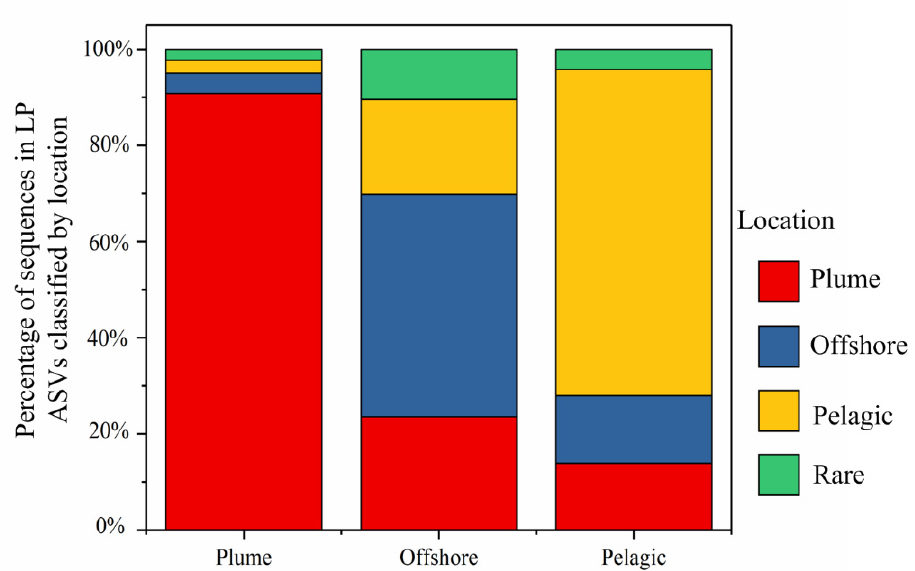
Figure 5. Percentage of sequences in LP ASVs classified by location. The rare category represents sequences belonging to ASV that make up to less than 0.1% of the total number of sequences from each corresponding location.